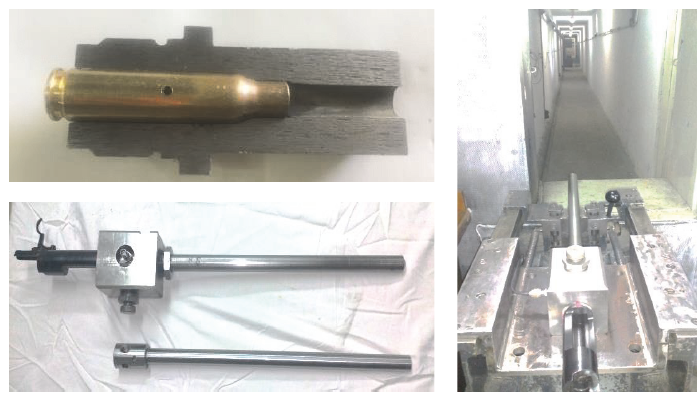
Figure 4: EPVAT system for case mouth pressure measurement.